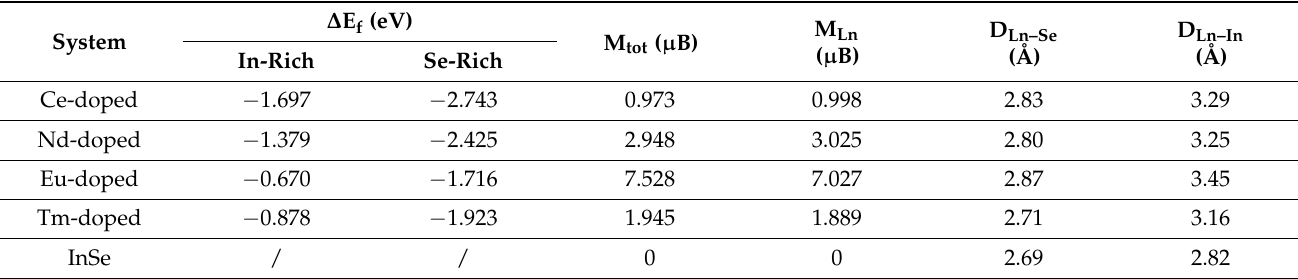
Table 1. The average Ln–Se bond length (d Ln–Se ) and Ln–In bond length (d Ln–In ), formation energy ( ∆ E f ), and total magnetic moment (M tot ) and magnetic moment of the Ln dopant (M Ln ) in the Ln-doped systems.